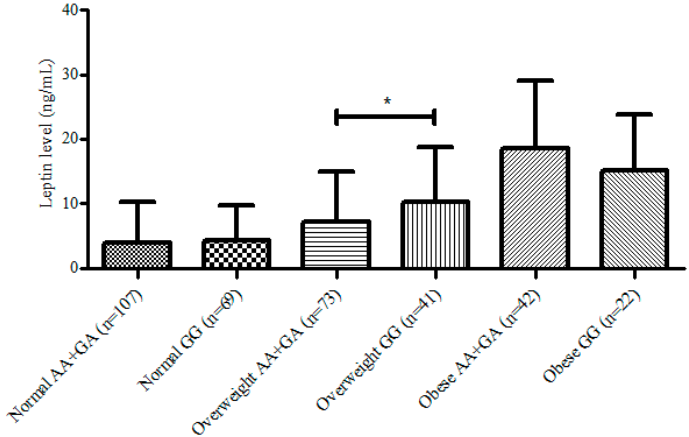
Figure 1. Difference in leptin production across genotypes and nutritional statuses. * Mann Whitney test p < 0.05.